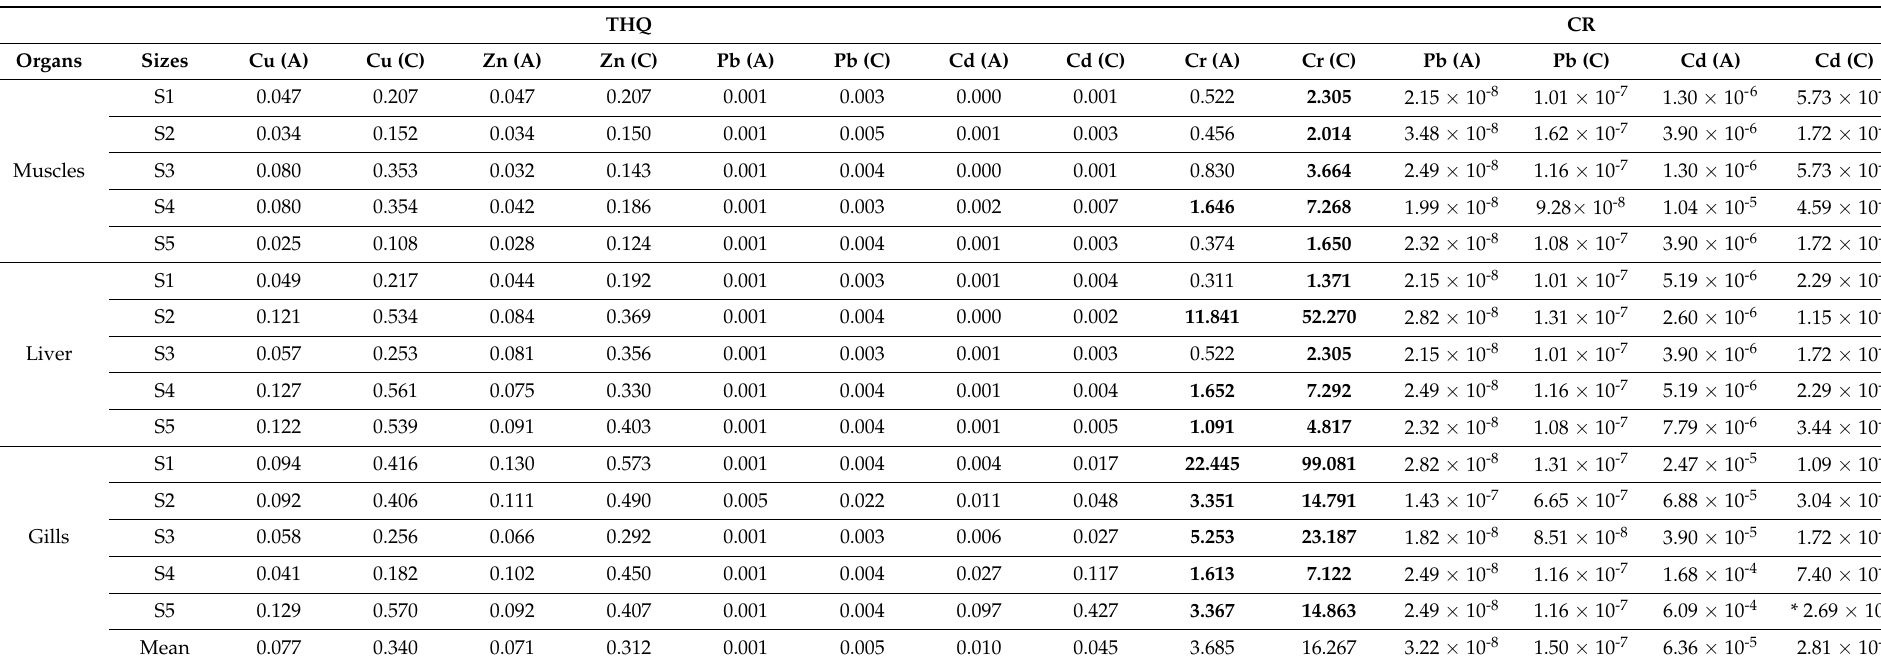
Table 4. Values of non-carcinogenic risks (THQ) and carcinogenic risks (CR) of different size classes of fish ( T. ilisha ) and their organs for adults (A) and children (C). Bold values indicate Hazard Index > 1, * = contained CR